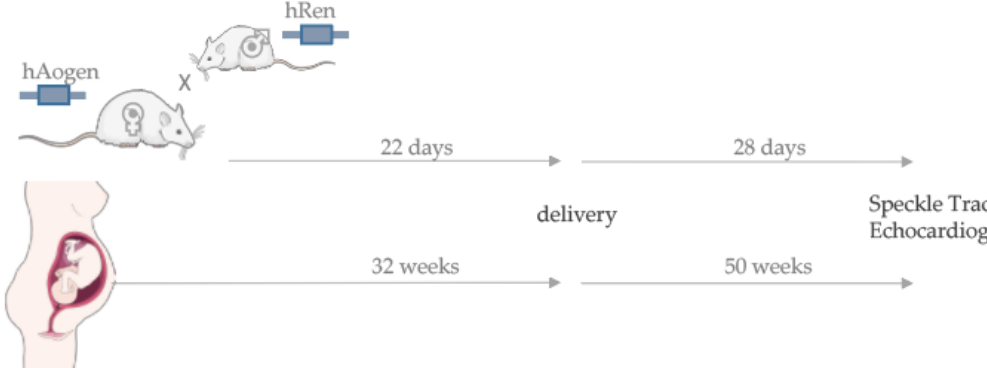
Figure 1. Formerly preeclamptic women and rats from a transgenic animal model were characterized postpartum regarding cardiac alterations in function and structure. Early onset preeclamptic women showed a lower gestational age than controls but were matched on scanning time after delivery.